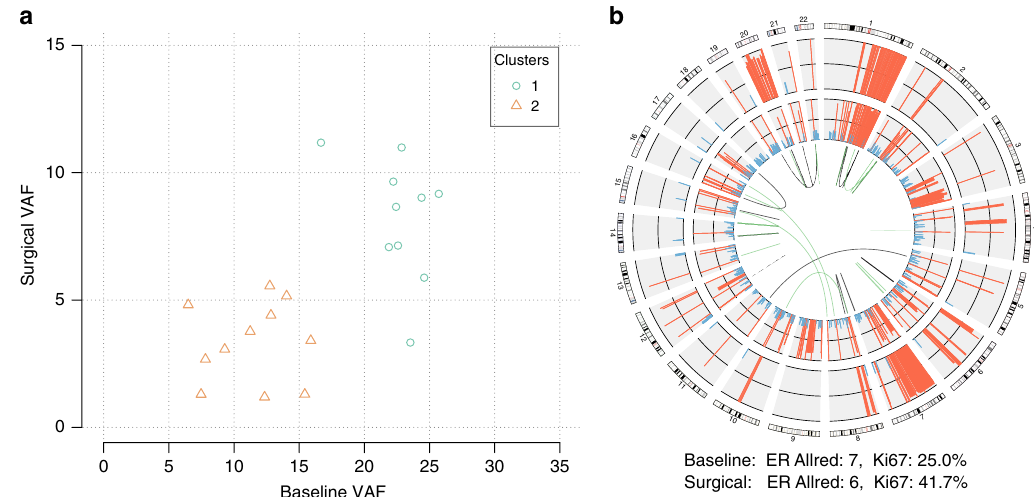
Figure 4 | Complex and stable clonal structure in BRC11. ( a ) Clonality plot comparing the variant allele fraction of SNVs in the baseline and surgical samples. ( b ) Gene fusions and copy number alterations. Outer ring: CN alterations in the baseline sample (amplifications in red, deletions in blue). Inner ring: CN alterations in the surgical sample. Centre: gene fusion events that were specific to the baseline (green) or surgical sample